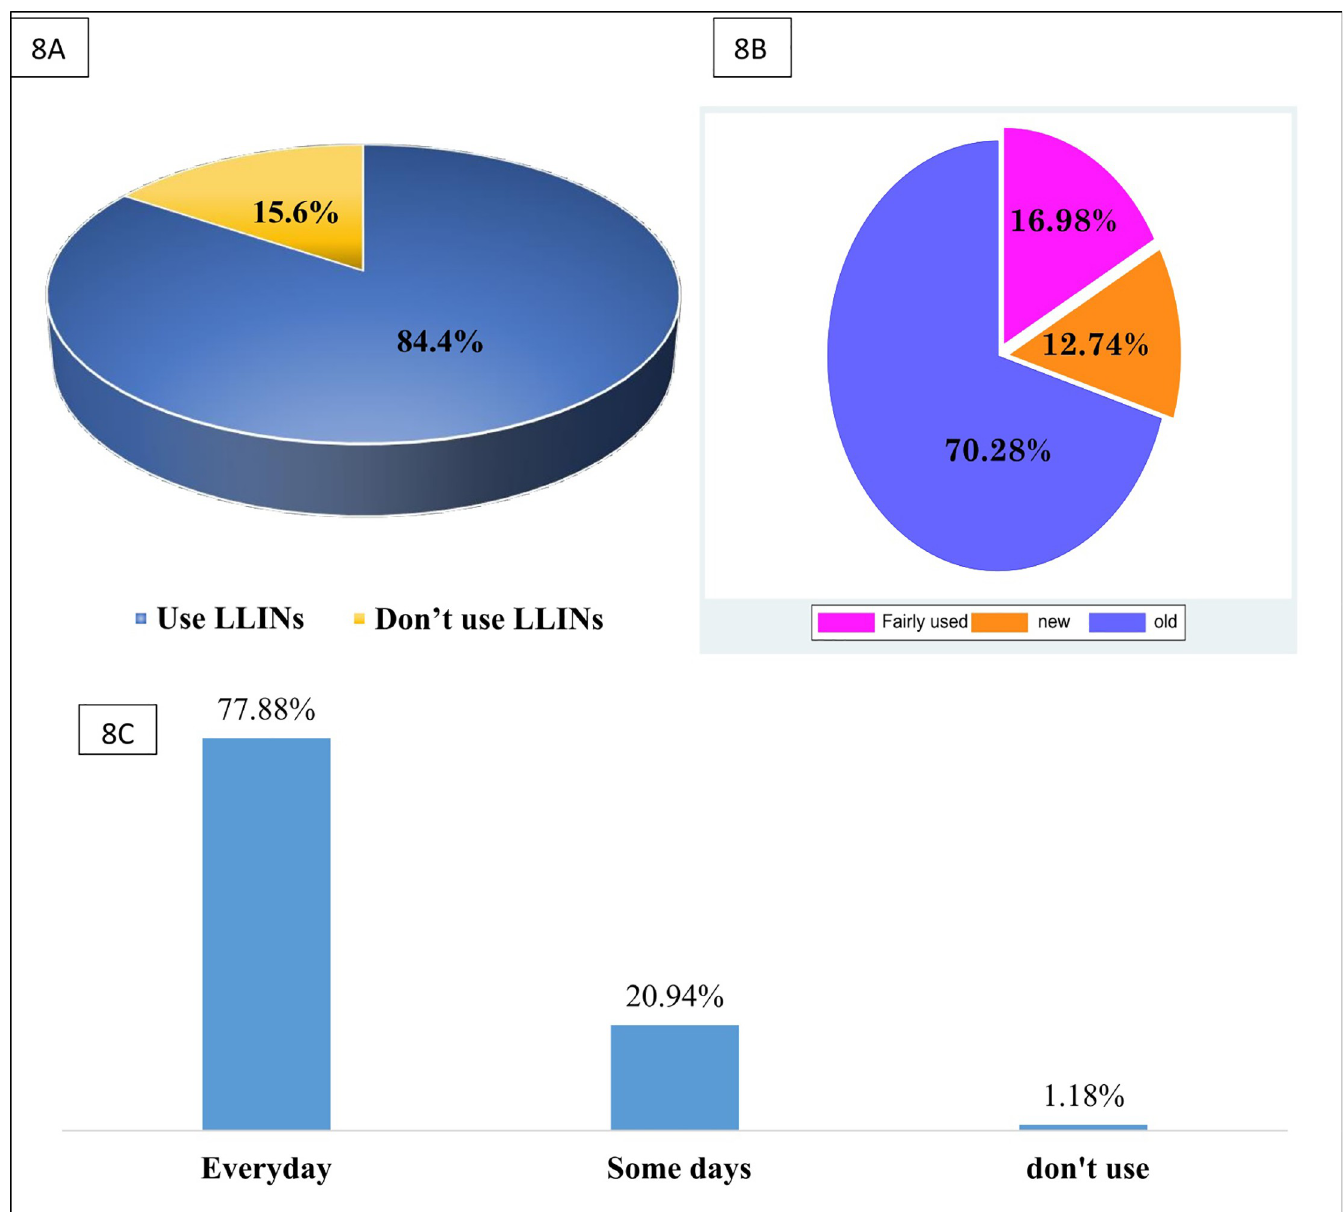
Fig 8. A: Percentage of LLINs ownership in Nkongho-Mbeng, B: State of LLINs used in Nkongho-mbeng (Old = LLINs acquired more than 3year ago, fairly use = LLINs acquired between one and three years, and new = LLINs that were less than a year old) and C: Frequency of LLINs usage in Nkongho-mbeng.